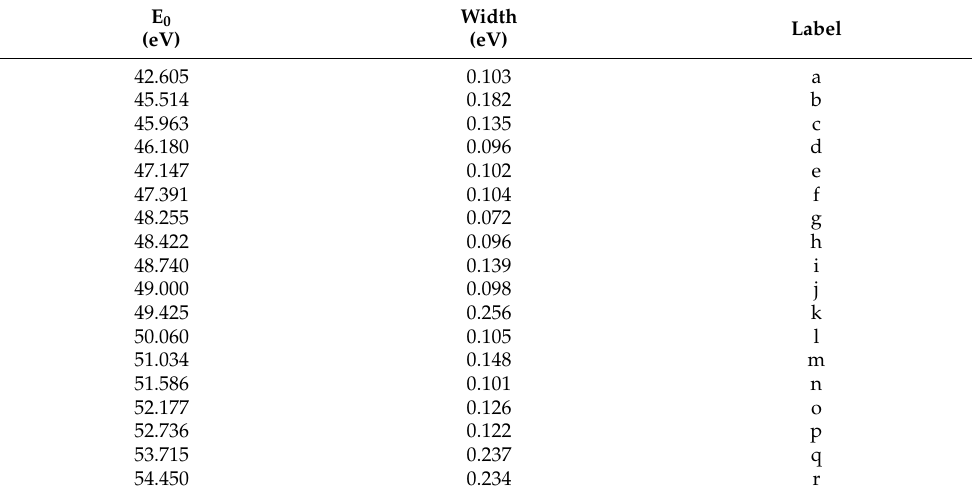
Table 2. Cl 2 + single-photon photoionization resonance energies E 0 and widths derived from Gaus- sian fits to the resonant peaks. Labels correspond to those in Figure 1.